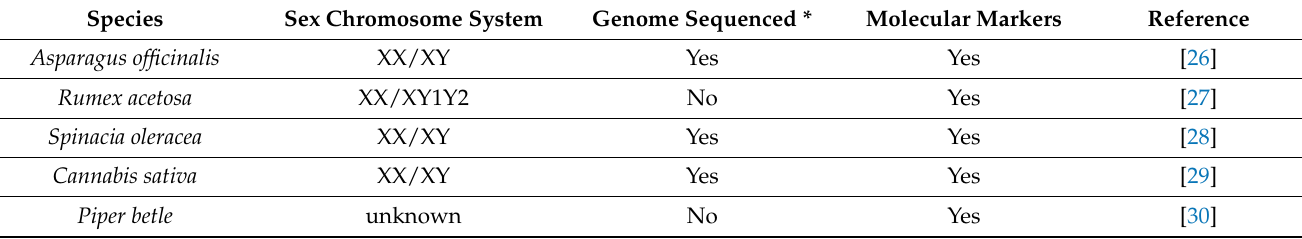
Table 1. Genetic characteristics of the most agriculturally important dioecious plants species.